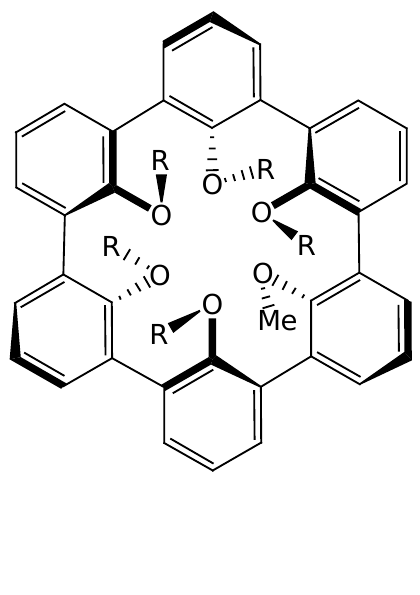
Figure 12. Calix [5]arene.